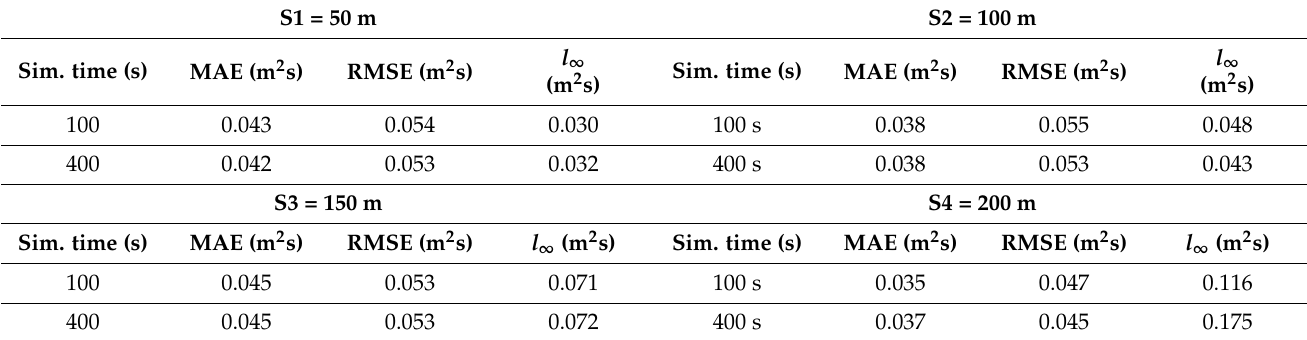
Table 10. MAE, RMSE and l ∞ norm for the spectral densities for the gauges S1, S2, S3 and S4 and simulation times of 100 and 400 s.